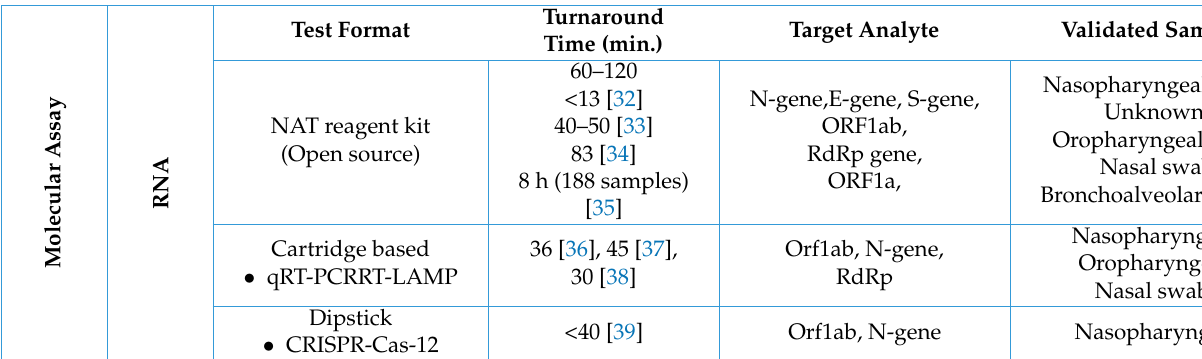
Table 1. Diagnostic Methods of